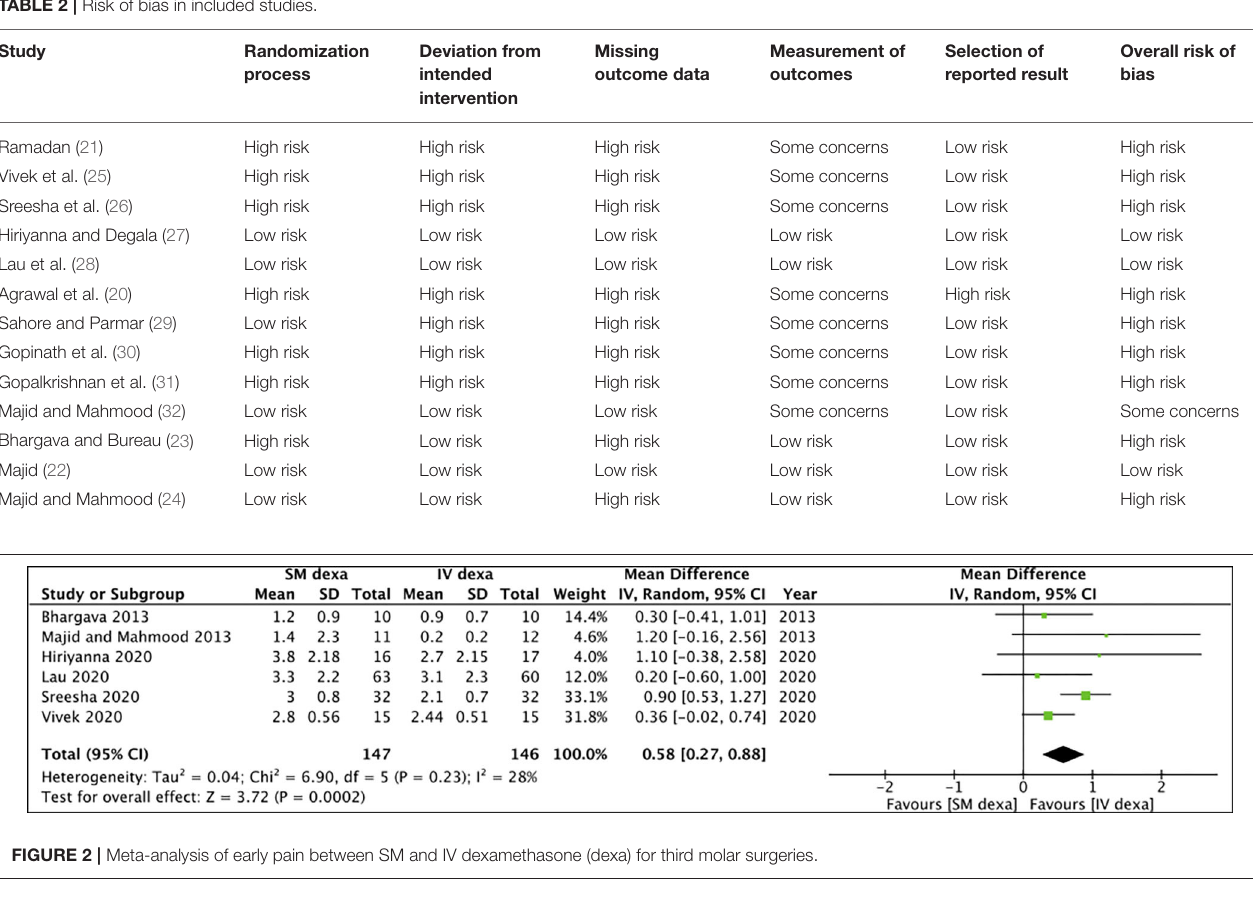
TABLE 2 | Risk of bias in included studies.